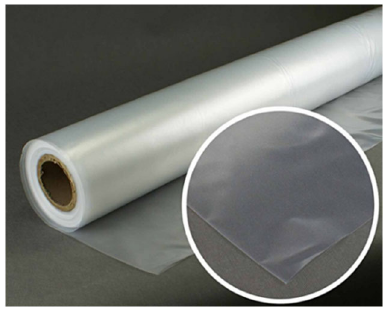
Figure 3. Dark spots.